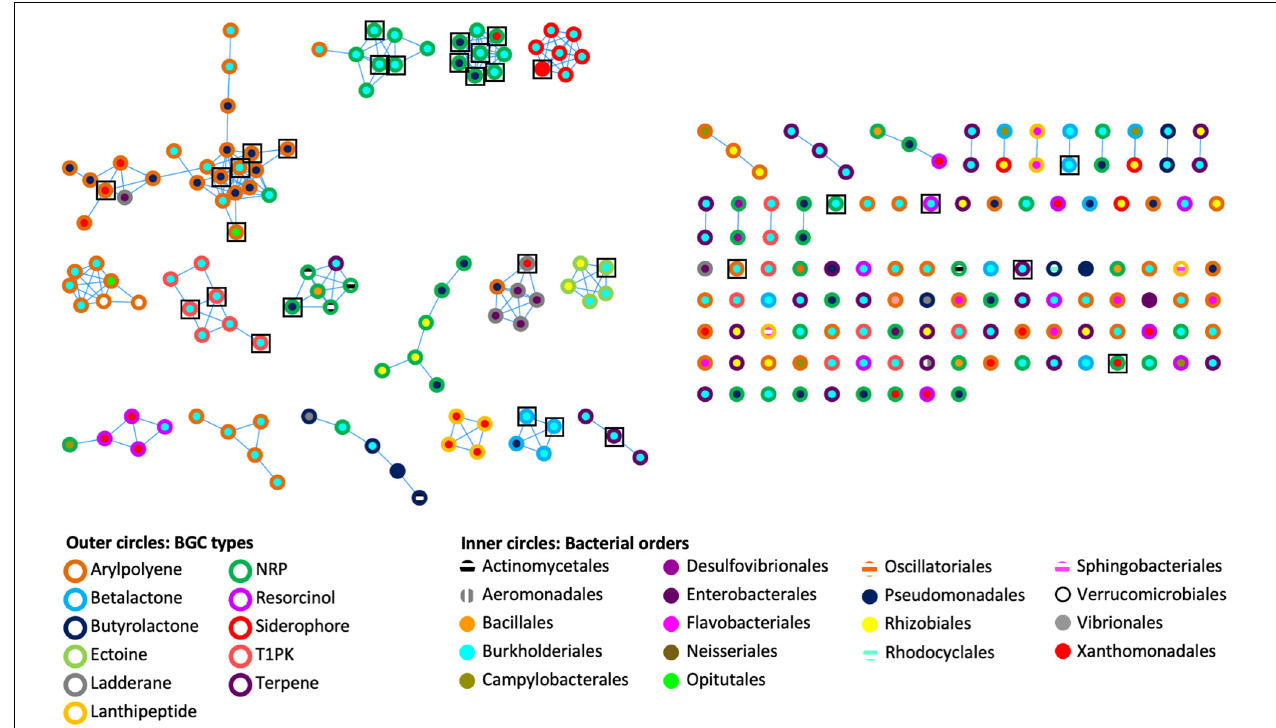
FIGURE 2 | Genetic networks of the BGCs identified in bacterial genomes and Cephalotes gut metagenomes. A distance threshold of 0.45 and an MCL index value of 2.0 were applied to generate the network. Color codes are respective for bacterial BGC type and bacterial order. Black squares represent the 31 BGCs found in bacterial genomes.